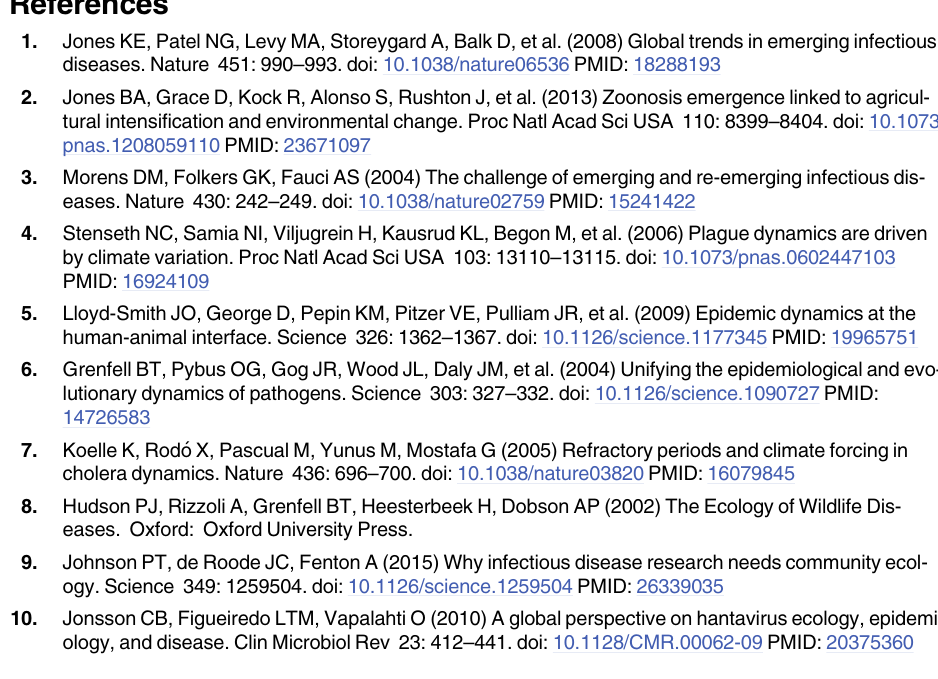
S1 Table. Sequences used in this study. S2 Table. Variables used in the TSIR